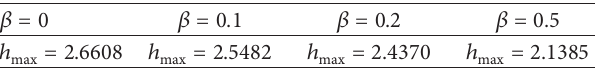
Table 2: The maximal allowable delay for different nonlinear parameters 𝛽 when 𝑘 is 0.1.